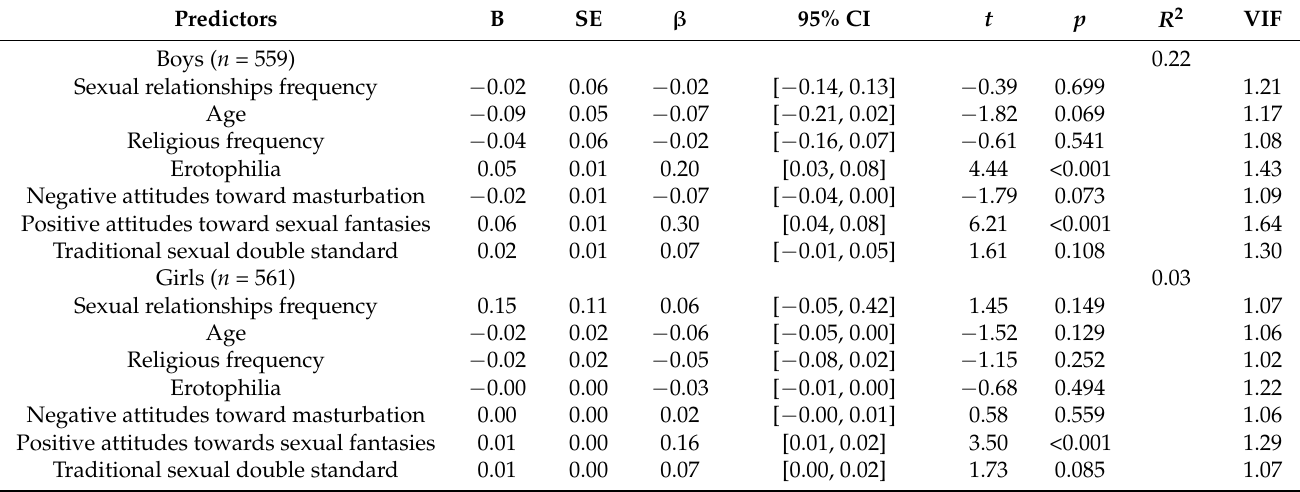
Table 3. Multiple regression models for masturbation frequency in boys and